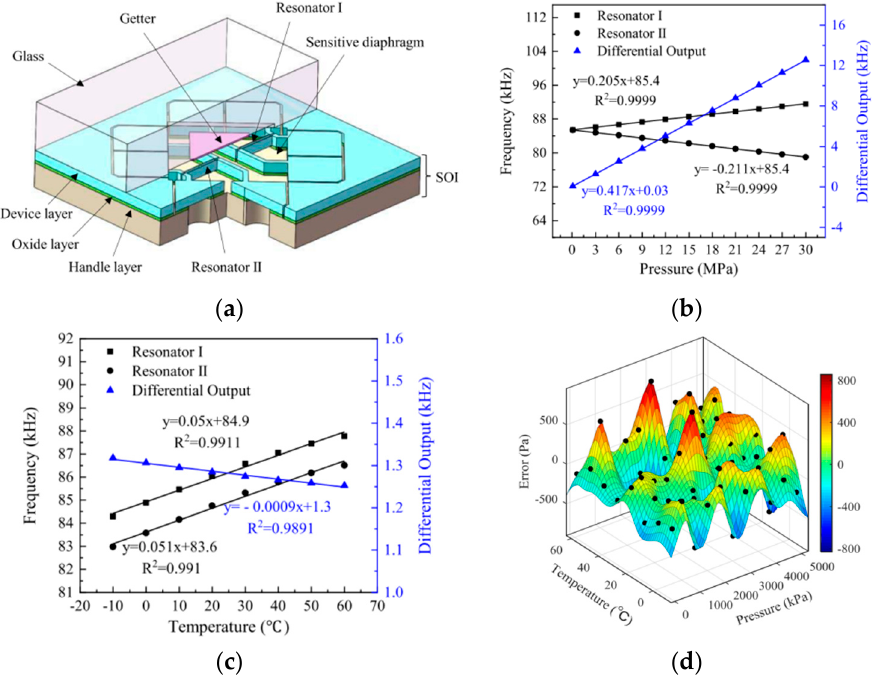
Figure 8. Resonant pressure sensor: ( a ) schematic diagram of structure; ( b ) high–pressure sensitivity in 20 °C; ( c ) temperature sensitivity under 110 kPa; ( d ) error of the pressure sensor after temperature compensations.